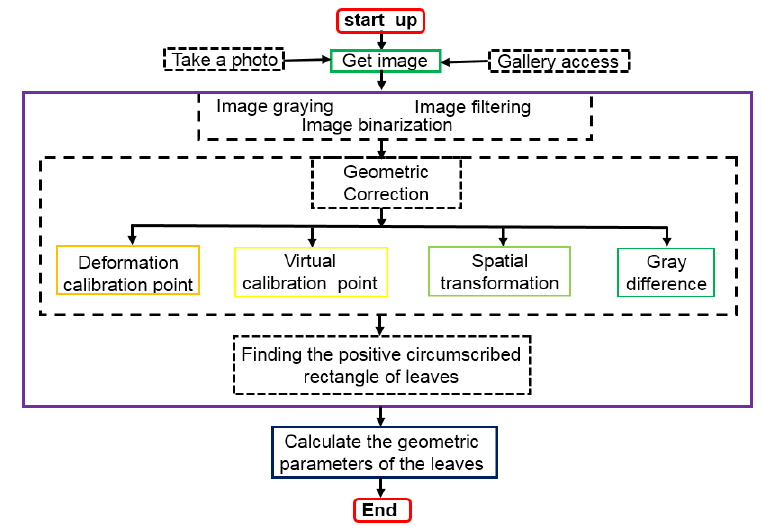
Figure 4. Software development process chart.